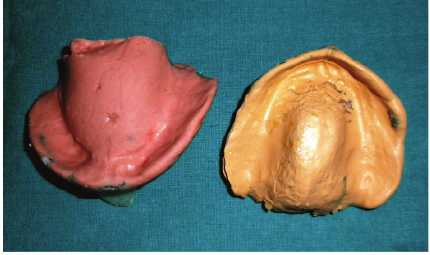
Figure 3: Final Impression.